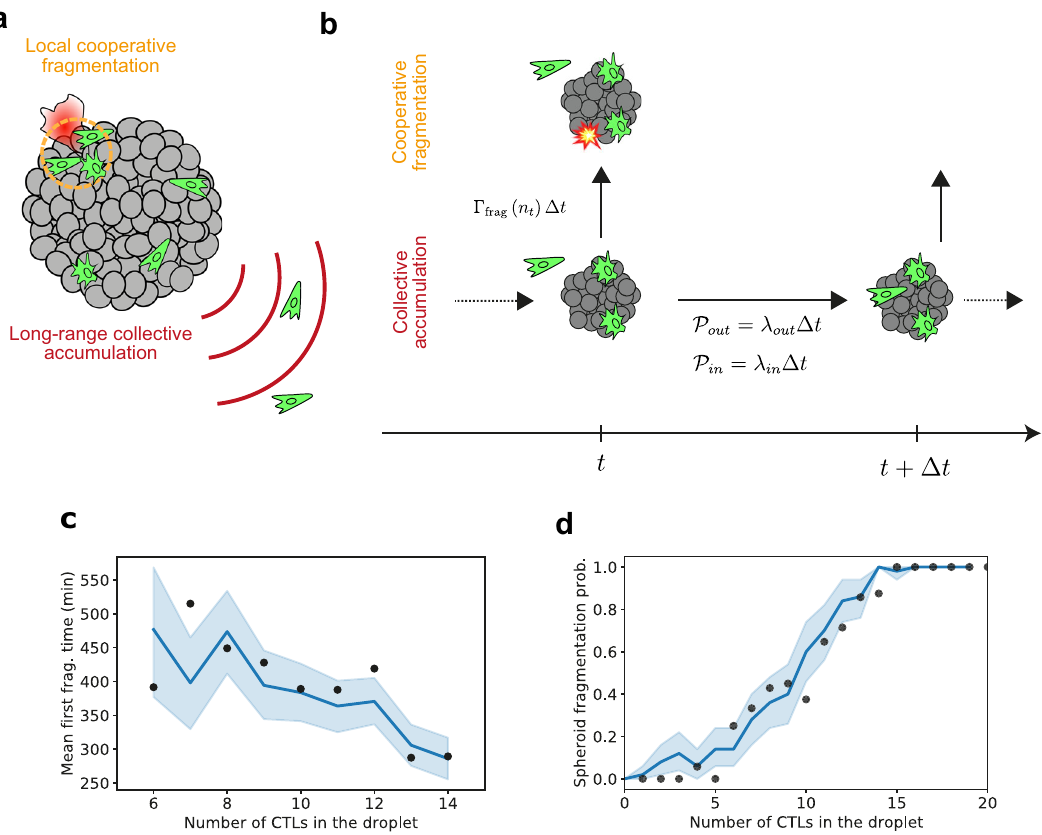
Fig. 6 Combining short and long-range interactions to simulate spheroid fate. a The concentration-dependent killing is modeled as the result of two complementary mechanisms: long-distance cooperative attraction of CTLs to the target site and local killing cooperation on the spheroid. b The evolution of the spheroid fate in the droplets can be modeled as a branching process: at each time step the spheroid can fragment with a probability Γ frag Δ t or not, and CTLs can either attach to or detach from the spheroid. c Simulations of the spheroid fate using the model in ( b ) and parameters obtained above recover the experimentally derived fi rst-fragmentation times. Shaded area represents the 95% con fi dence interval of simulated data. The bold line represents the mean. d Experimental (black dots) and simulated (blue line) spheroid fragmentation probability as a function of the number of CTLs in the droplet. Shaded area represents the 95% con fi dence interval of simulated data. The bold line represents the mean. Source data are provided as a Source data fi le.